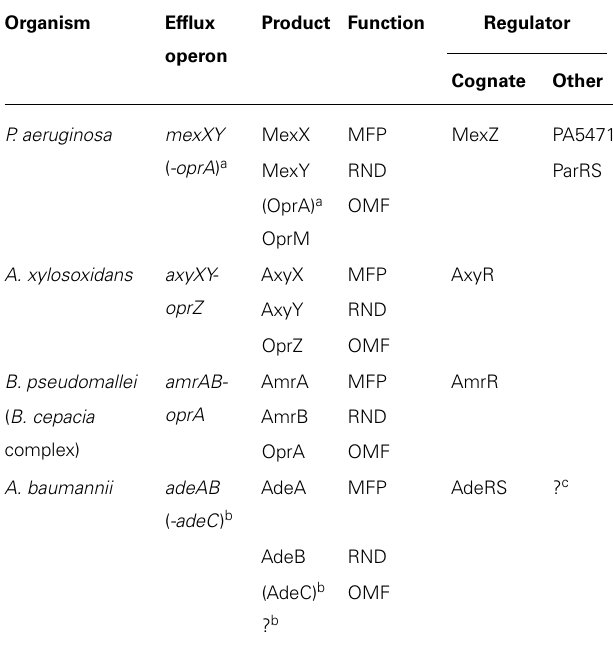
Table 1 | Genetic organization of aminoglycoside efflux operons of clinical significance and their regulators in non-fermentative Gram-negative